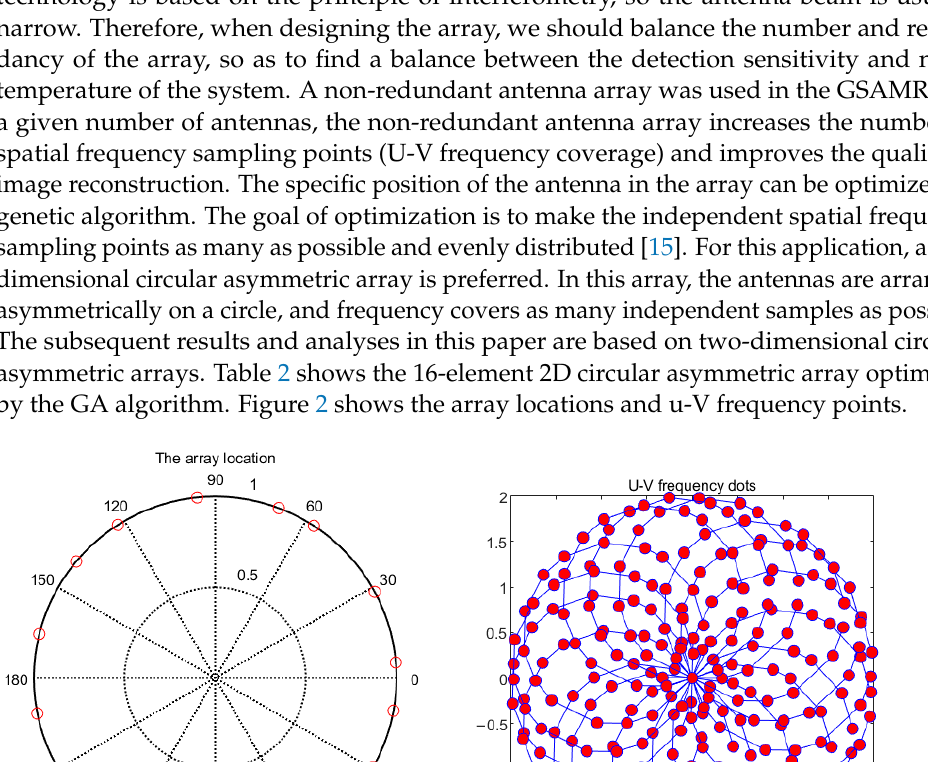
Table 2. 16 cells two-dimensional circle-asymmetric array.